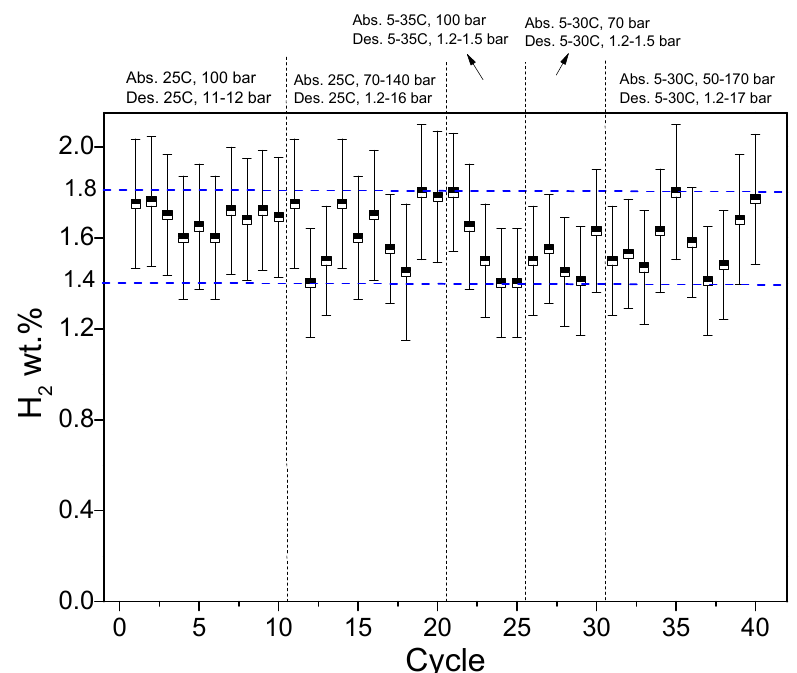
Figure 7. Hydrogen capacity upon cycling for (Ti 0.9 Zr 0.1 ) 1.25 Cr 0.85 Mn 1.1 Mo 0.05 + 10 wt.% ENG after activation. Values of dehydrogenation capacity (m = 300 mg, Sieverts apparatus [62]).